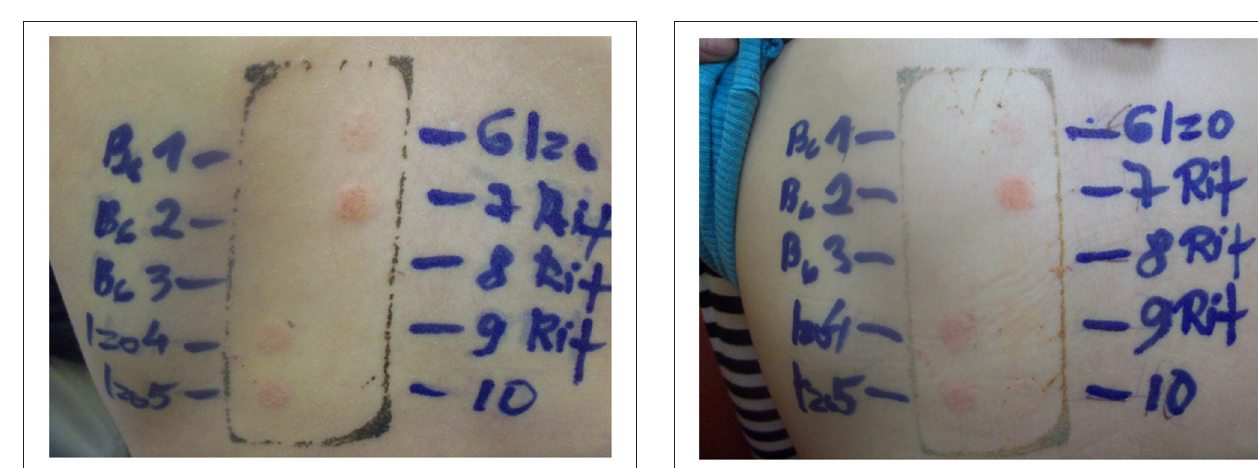
FIGURE 1 | Skin patch test after 72h. FIGURE 2 | Skin patch test after 168 h. Follow-up after 5